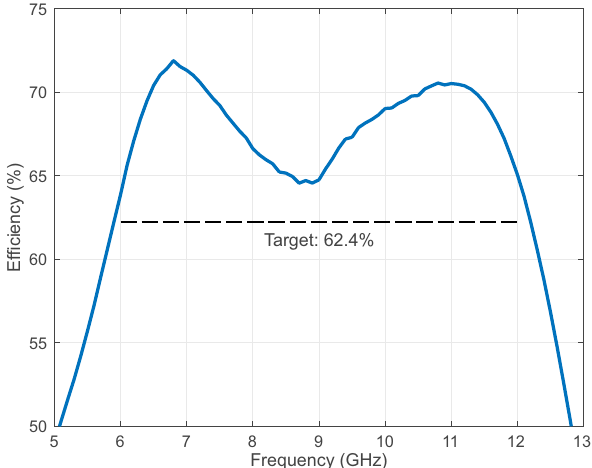
Figure 11. Efficiency vs. frequency at 5.5 dB compression for the PA using the matching network designed for the 0.5 dB efficiency